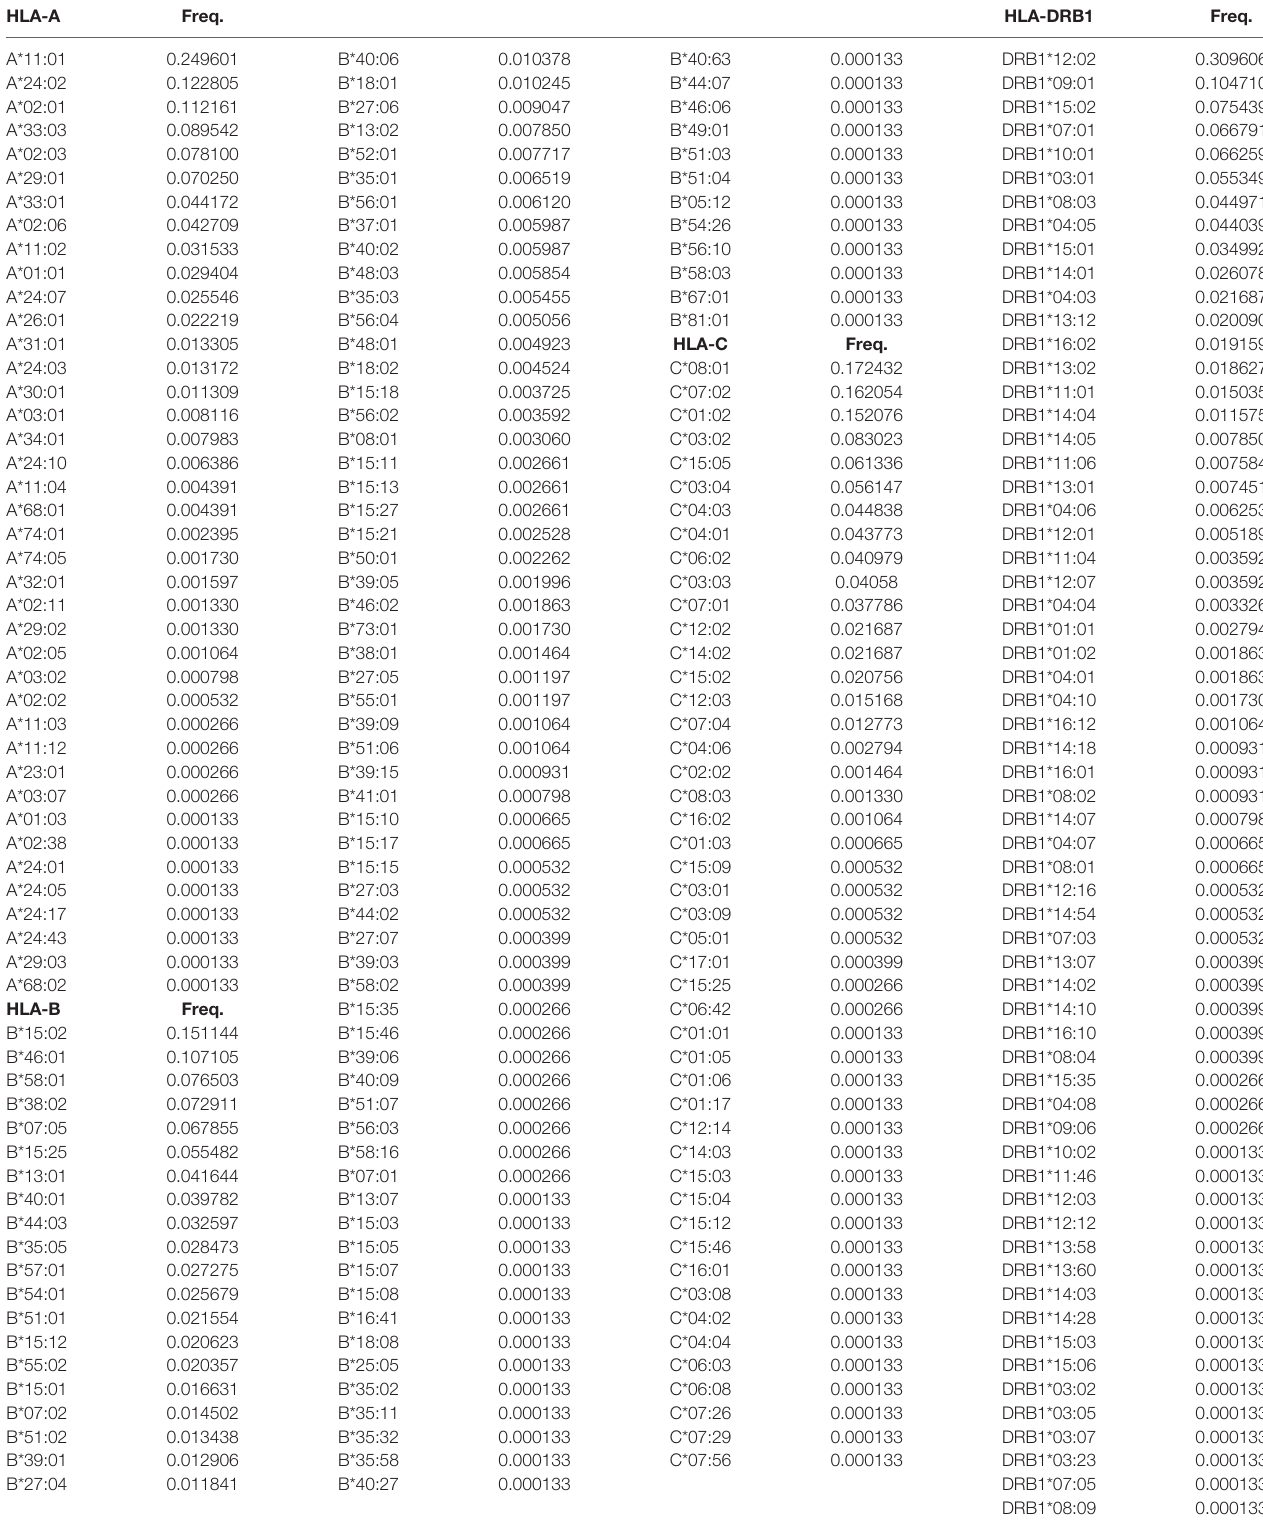
TABLE 2 | HLA-A, -B, -C, and -DRB1 allele frequencies in cord blood of the Kinh Vietnamese donors. HLA-A Freq. HLA-DRB1